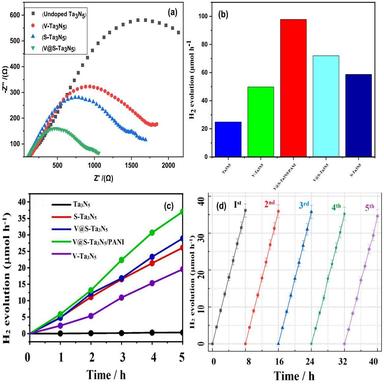
(a) Nyquist plot of undoped Ta3N5, V-doped Ta3N5, S-Ta3N5, and V@S codoped-Ta3N5, (b) shows the H2 evolution activity of the pristine Ta3N5, and the synthesized materials V-doped Ta3N5, S-Ta3N5, and V@S codoped-Ta3N5, (c) H2 evolution activity of the synthesized materials with time, and (d) displays the recyclability of the photocatalyst to check the stability up to 5 cycles.